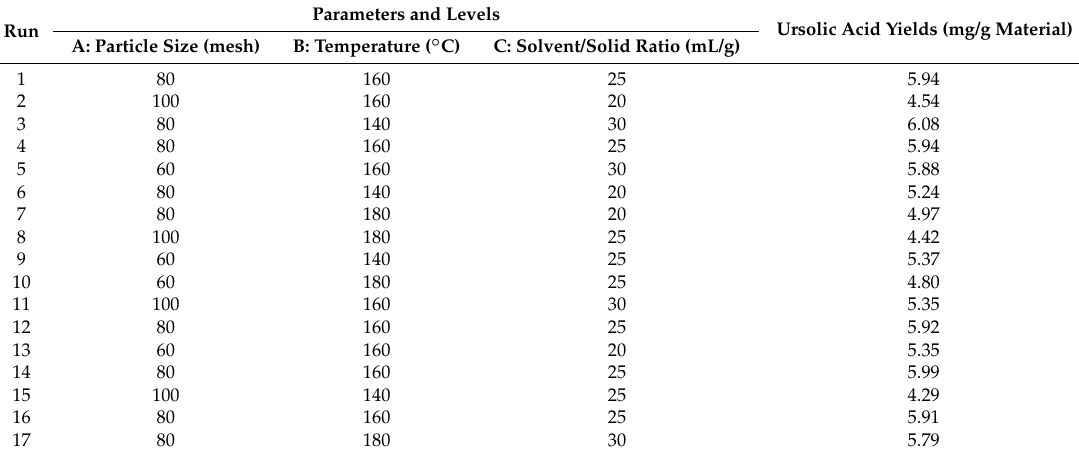
Table 1. Box–Behnken design with independent variables and response